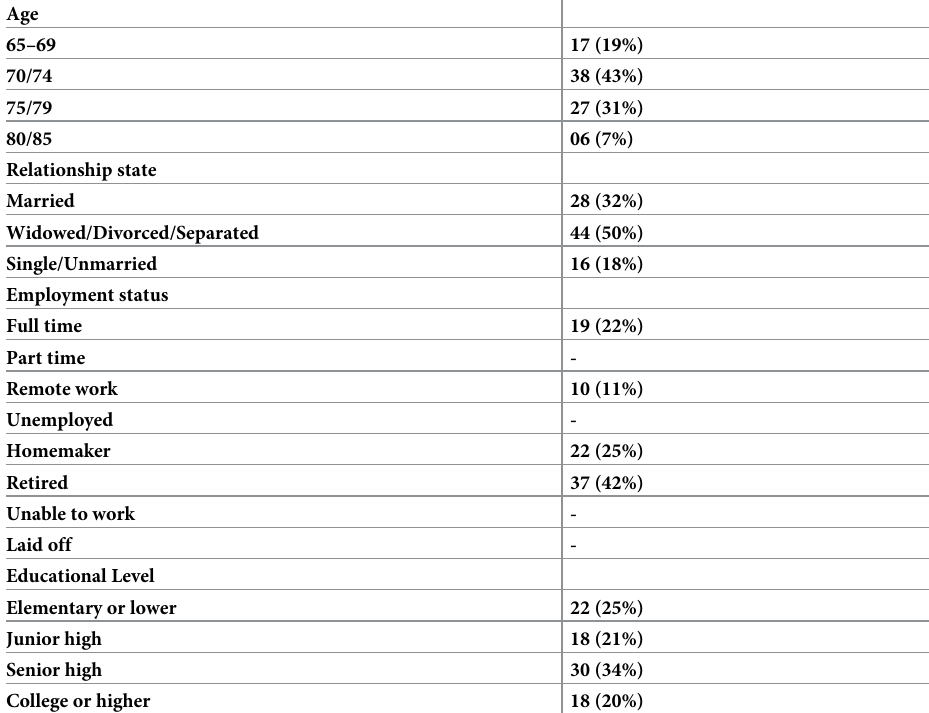
Table 1. Participants’ socio-demographic characteristics(n =